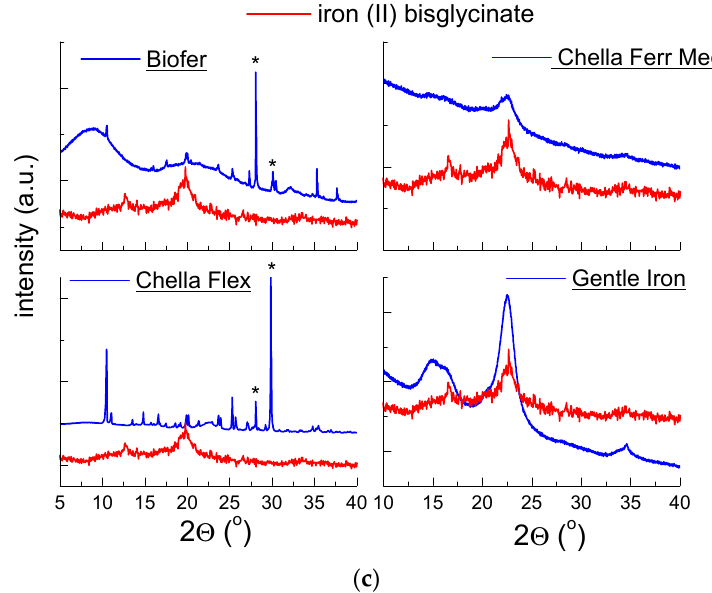
Figure 5. Diffraction patterns for dietary supplements: ( a ) Balanced Iron Complex , Iron Plus , Iron Complex Now , Szelazo SR , ( b ) Ferrum DOZ , Chella Ferr Forte , X-Ferr , Chella Ferr Bio , ( c ) Biofer , Chella Ferr Med , Chella Flex , Gentle Iron , *—vitamin C. Table 4. Comparison of experimental data of dietary supplements containing iron (II) bisglycinate with the experimental data for pure iron (II) bisglycinate.